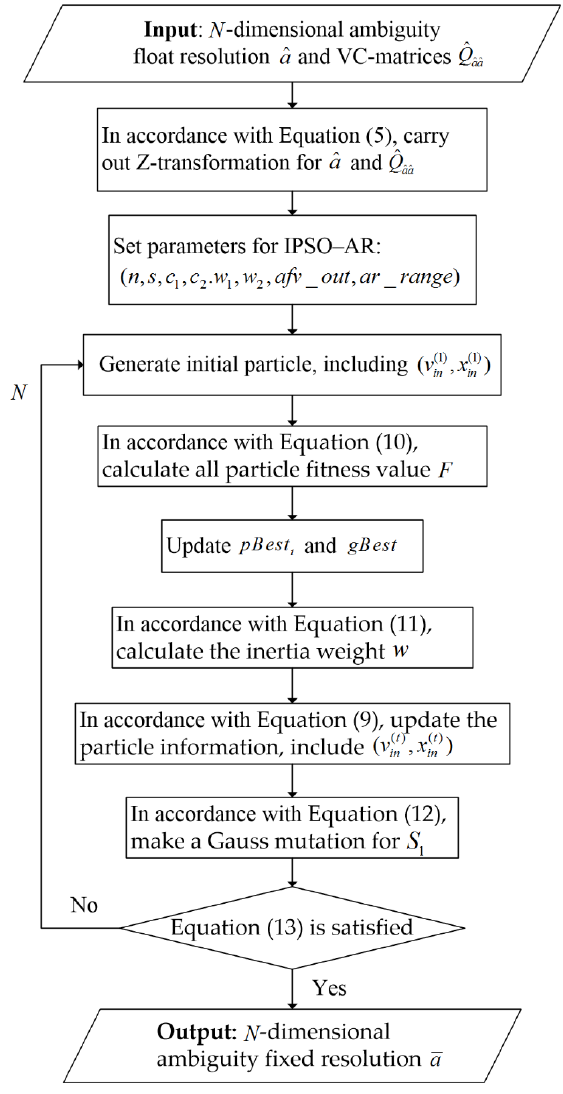
Figure 1. Flow diagram of IPSO–AR (improved particle swarm optimization–ambiguity resolution).